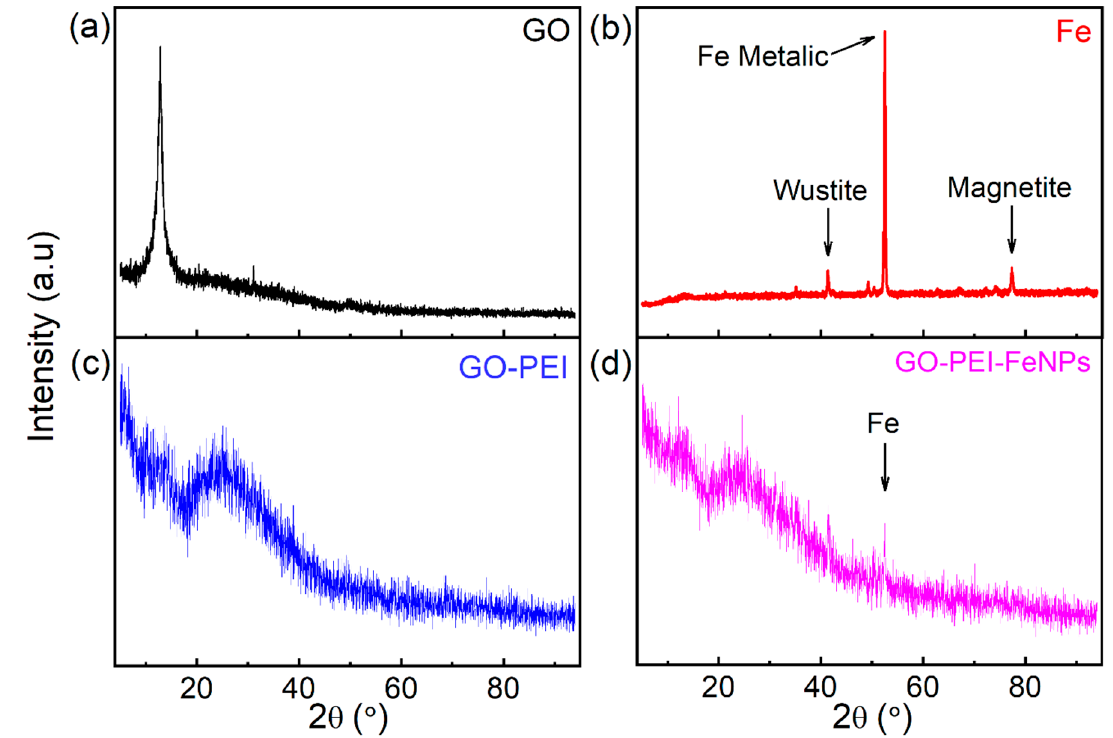
Figure 4. XRD diffractogram of ( a ) GO, ( b ) metallic iron, ( c ) GO–PEI and ( d ) GO–PEI–FeNPs. Figure 4. XRD di ff ractogram of ( a ) GO, ( b ) metallic iron, ( c ) GO–PEI and ( d )